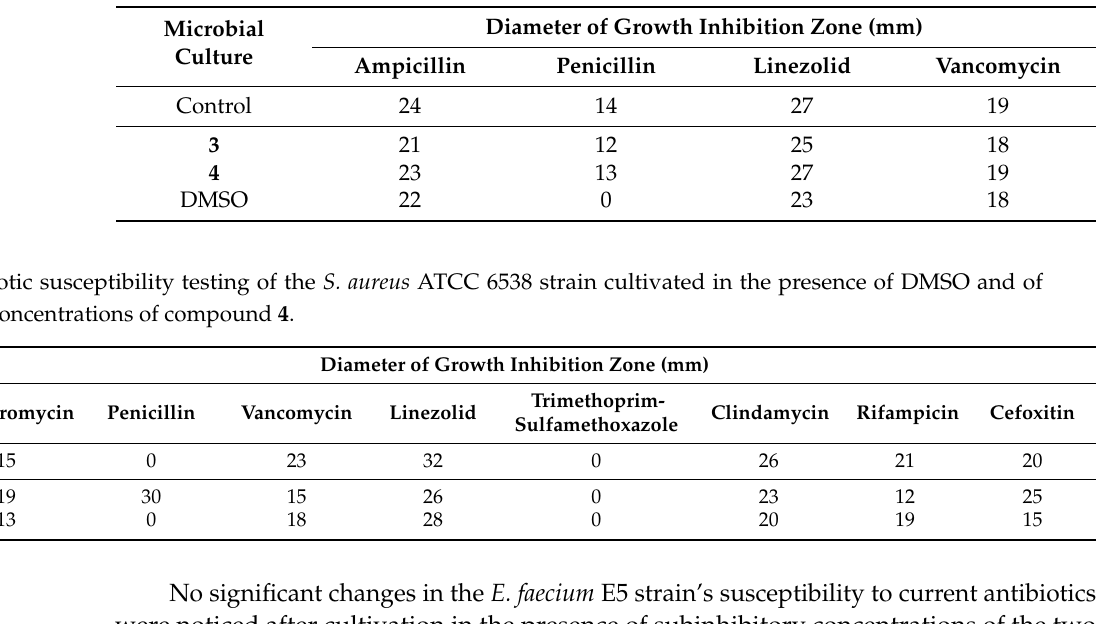
Table 2. Antibiotic susceptibility testing of the E. faecium E5 strain cultivated in the presence of DMSO and of sub-inhibitory concentrations of compounds 3 and 4 .